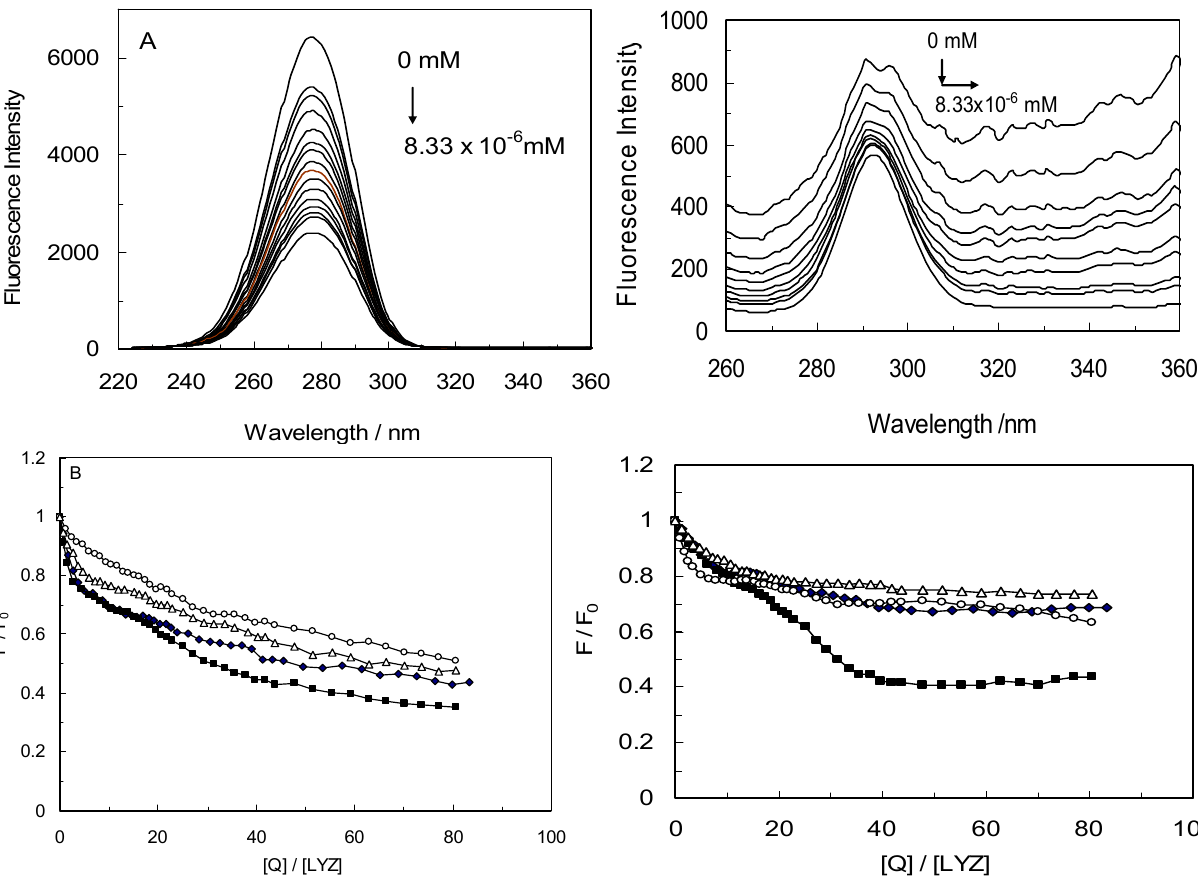
Figure 6. ( A ) Synchronous fluorescence spectra of LYZ in the presence of CYC, at ∆λ = 60 nm (right ∆λ = 15 nm). ([LYZ] = 1 × 10 − 3 mM, [CYC] = 5 × 10 − 5 mM, pH = 7.4, T = 298 K); ( B ) comparison of curves of F/F versus [Q] for the binary LYZ-CYC( ♦ ), 0 ternary [LYZ-CD( α )]CYC( ■ ), [LYZ-CD( β )]CYC( ○ ), [LYZ-CD( γ )]CYC( Δ ), systems